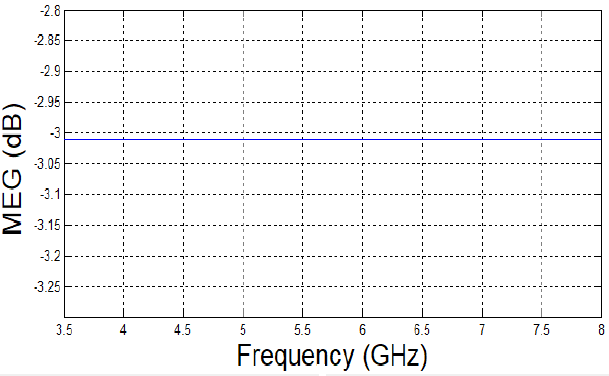
FIGURE 10: MEG of MIMO